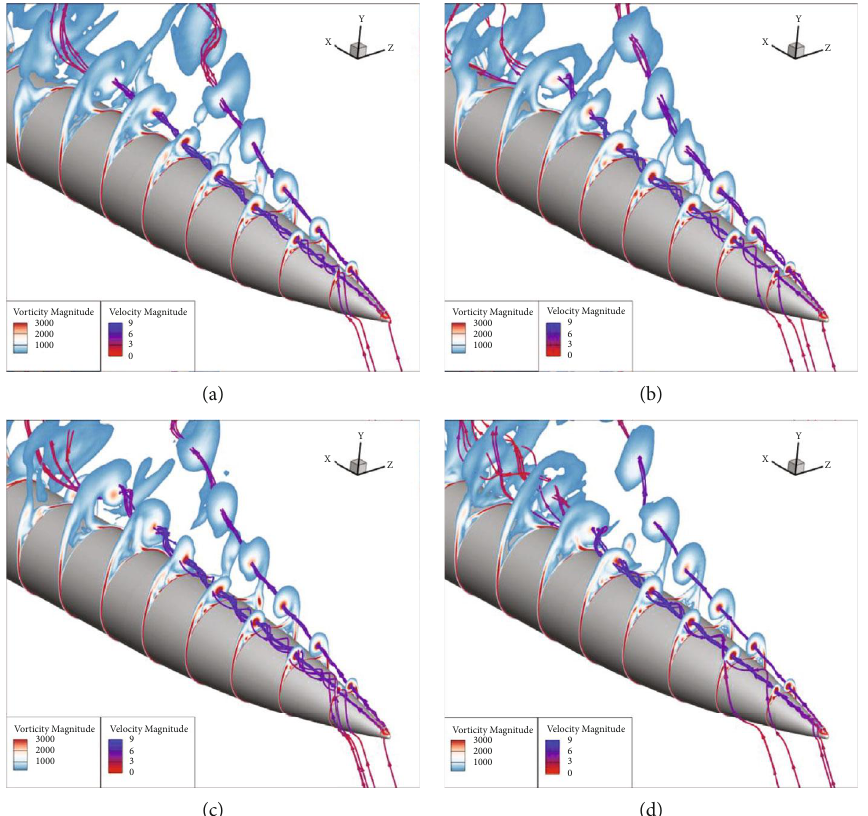
Figure 22: Comparison of vorticity and streamline on the left side with di ff erent values of roughness: (a) Model 1, (b) Model 2, (c) Model 3, and (d) Model